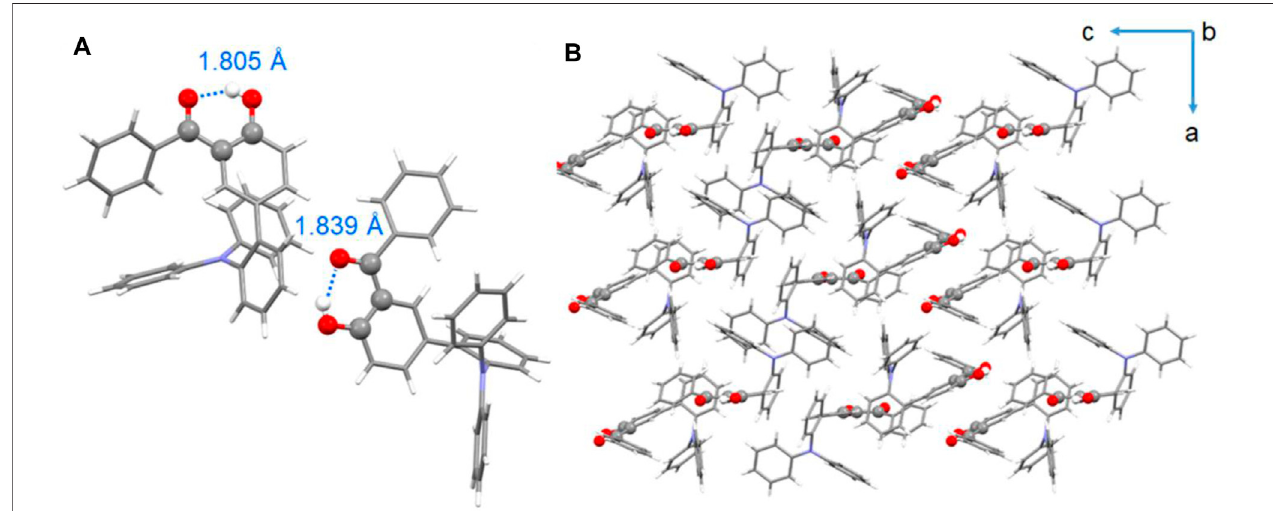
FIGURE 4 | (A) Single-crystal structures of BPOH-TPA (C − H ··· O intramolecular hydrogen bonds are labeled in blue) and (B) packing mode of BPOH-TPA from b axis view.